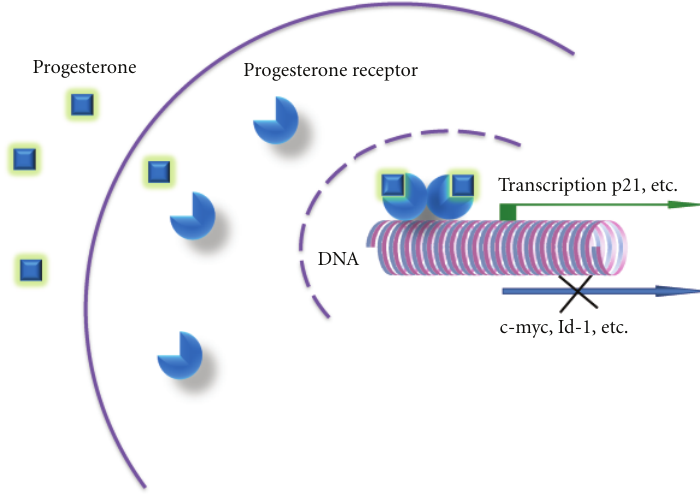
Figure 2: Pg suppresses proliferation and invasion of both salivary gland and breast cancer cells. In our recent studies, the inhibitory e ff ect of Pg on the proliferative and invasive activities of the salivary gland and breast tumor cells was demonstrated, suggesting some common mechanisms. In both types of cancers, expression of Id-1 and c-myc was downregulated after Pg treatment, whereas p21 expression level was